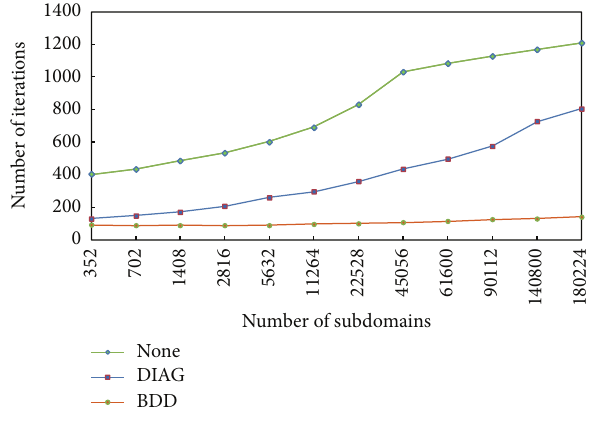
Figure 4: Numerical scalability.